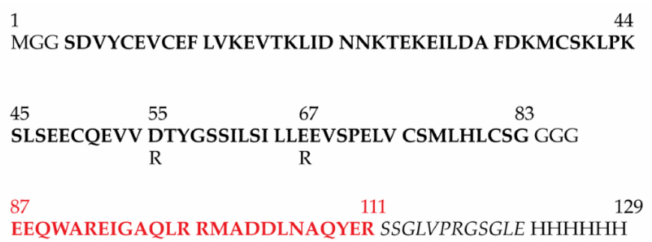
Figure 2. Amino acid sequence of engineered protein chimera sapC-PUMA and double-mutant sapC-PUMA-DM: The amino acid sequences (one letter code) of sapC (native sequence from residues S4 to G83) and PUMA BH3 (residues E87 to R111) are shown in bold black and bold red, respectively. Mutations in the sequence of sapC-PUMA-DM (D55R, E67R) are indicated. The thrombin cleavage site is in italics followed by the six-histidine